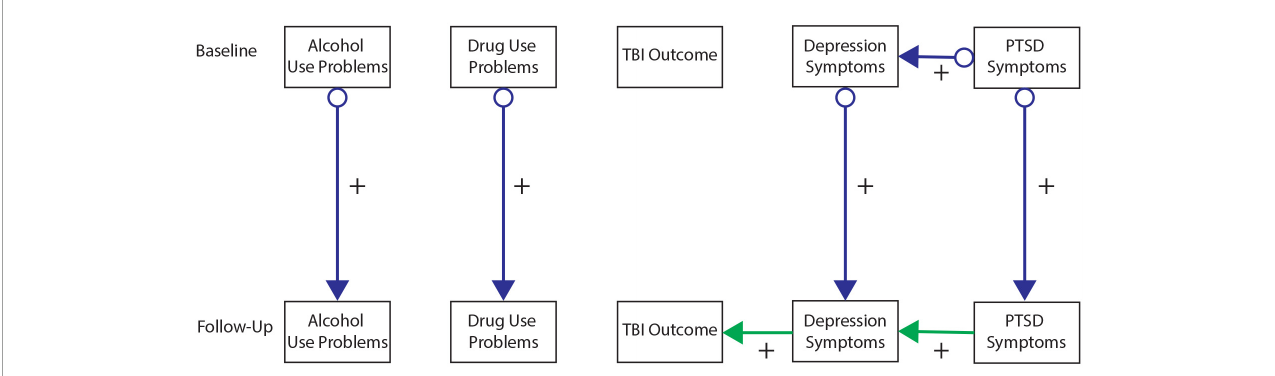
FIGURE5 Greedy Fast Causal Inference (GFCI) graph for the CENC-ADAPT sample ( n = 243). Third independent replication of causal links between post-traumatic stress disorder (PTSD) symptoms and depression over the course of 6–24 months follow-up in the CENC-ADAPT sample, leading to severity of traumatic brain injury (TBI) outcome, which are all independent of drug and alcohol use problems. Colored arrows indicate the level and directionality of the causal edges, with + or – along the edges indicating whether these links cause increases or decreases in scores on the connected measures.